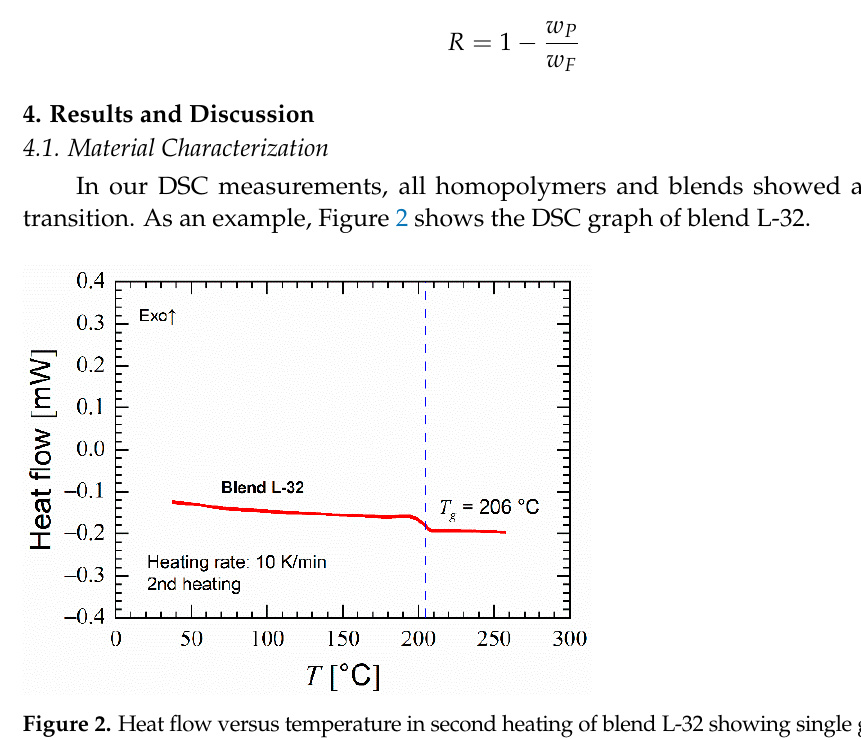
( b ) Figure 3. Glass transition temperature versus weight concentration of PVP in blends and predictions of Equations (1) and (2) based on glass transition temperatures of homopolymers; ( a ) Blends with PESU E 2010 (L-x) ( b ) Blends with PESU E 3020 P (H-x).